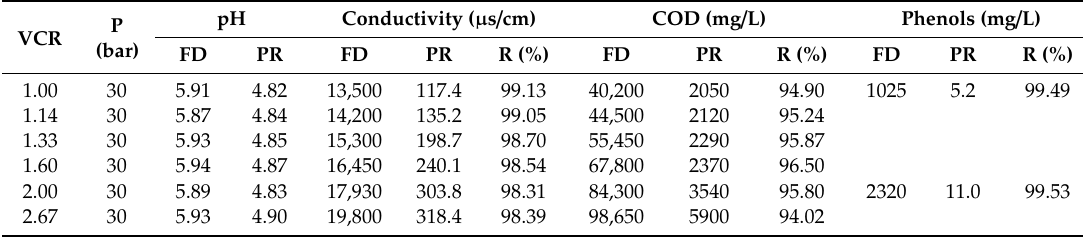
Figure 11. Effect of storage of OMW2-CA on the permeate flux as a function of VCR during RO test with the MF permeate of OMW2-CA. Table 8. Main physicochemical properties of feed (FD) and permeate (PR) samples collected during the RO test with “aged” OMW2-CA.